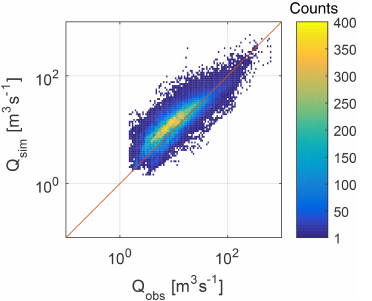
Figure 2. Performance of the hydrological model: density plot of observed vs. simulated hourly discharges at the outlet of the river basin for the period 2004–2016.